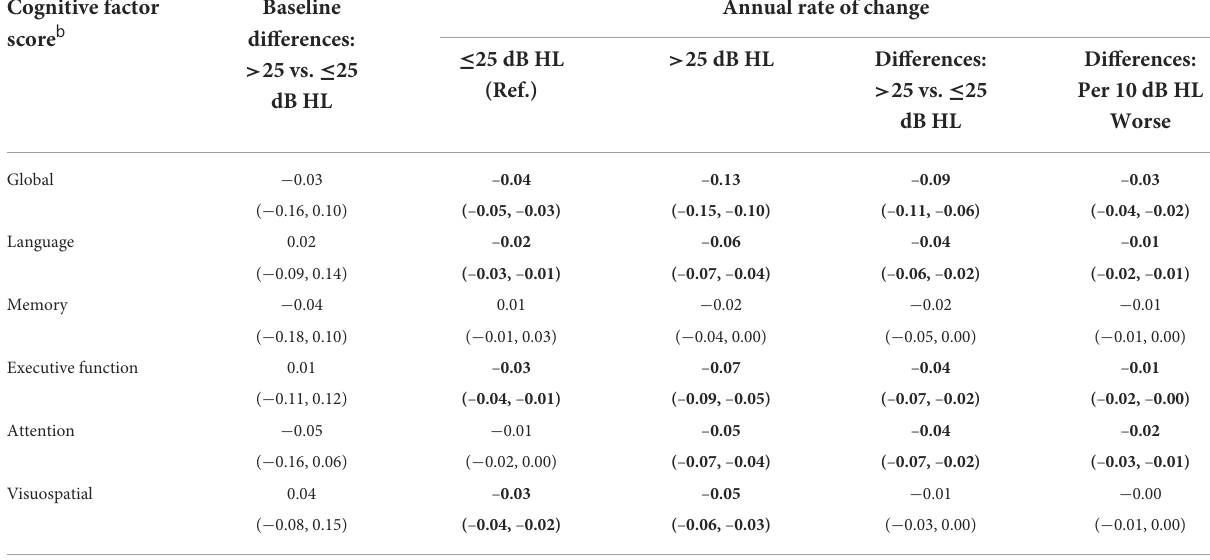
TABLE 4 Multivariable-adjusted associations a of audiometric hearing with cognitive performance in the Baltimore Longitudinal Study of Aging 2012–2019 ( N =